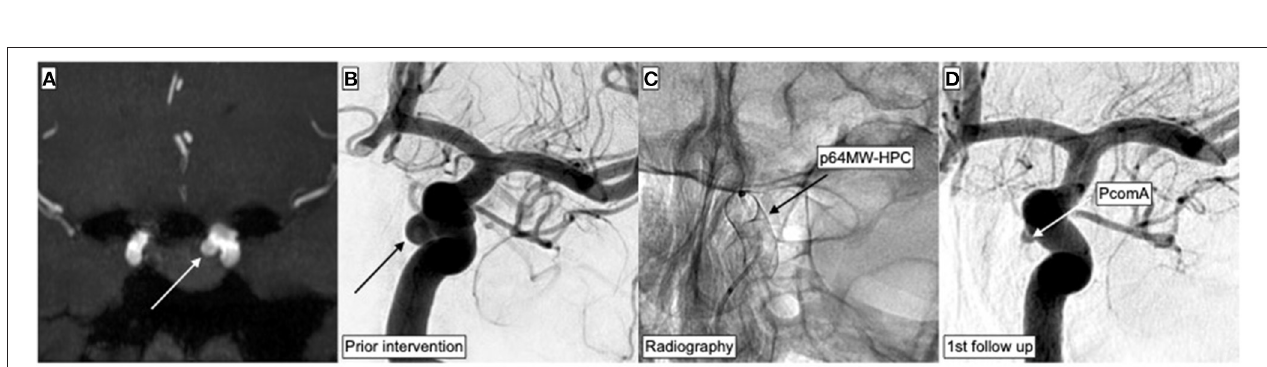
FIGURE 2 | Endovascular treatment of a wide-necked, partially thrombosed giant aneurysm arising from the side wall of the basilar artery, which had been treated with stent-assisted coiling 6 years earlier but without any follow-up. The aneurysm relapsed and caused brain stem compression. (A) Time of flight angiography (TOF) shows the partially thrombosed basilar artery aneurysm (white arrows) compressing the brain stem. (B) Device radiography demonstrates the separation of the previously implanted Neuroform stents (white arrow) and substantial deformation of the coil package. (C) DSA image corresponding to the radiography in (B) . The gap between the stents corresponds to the broad neck of the aneurysm. The same projection was used for FDS implantation. (D) The p64MW-HPC was implanted within the Neuroform stents in order to bridge the gap between the separated devices and provide a scaffold for the formation of a neo-intima along the neck of the aneurysm.